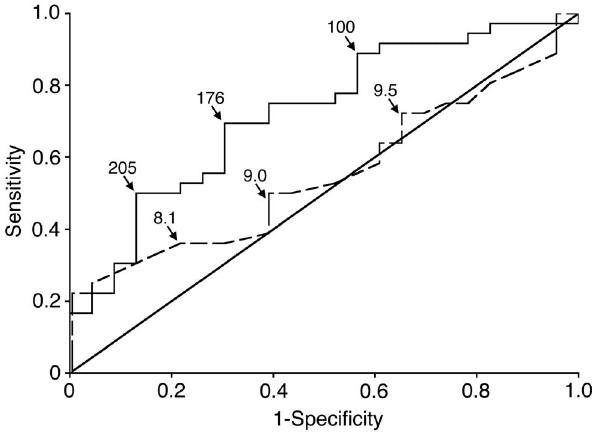
Figure 3. Receiver operator characteristic (ROC) curve analysis. ROC curve comparing the patients who required or did not require hospitalization within the first 3 years of life. Absolute reticulocyte count (solid line) hemoglobin level (dashed line) values at selected points (arrows) along the ROC are included. Sensitivity is shown on the y-axis, and 1-specificity is listed on the x-axis. p values represent significance of area under the curve. ARC, Absolute Reticulocyte Count; Hb, hemoglobin; AUC, area under the curve with 95% confidence intervals (CI).